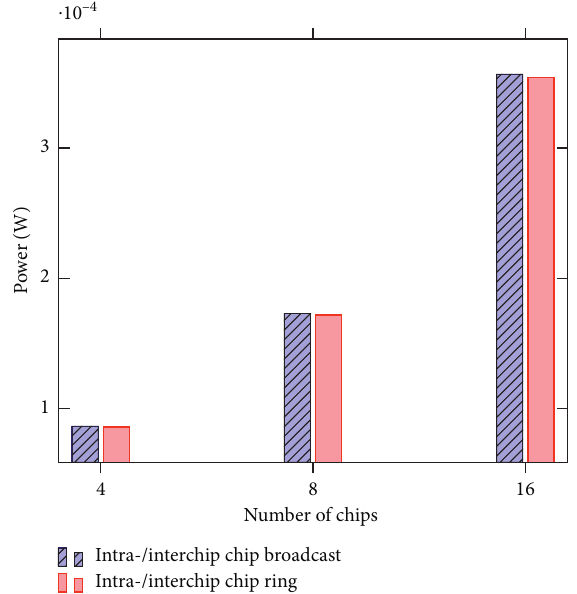
Figure 16: The power consumption of the proposed THz multichip system in comparison with the token-based mm-wave one with varying system size (PIR � 0.5).